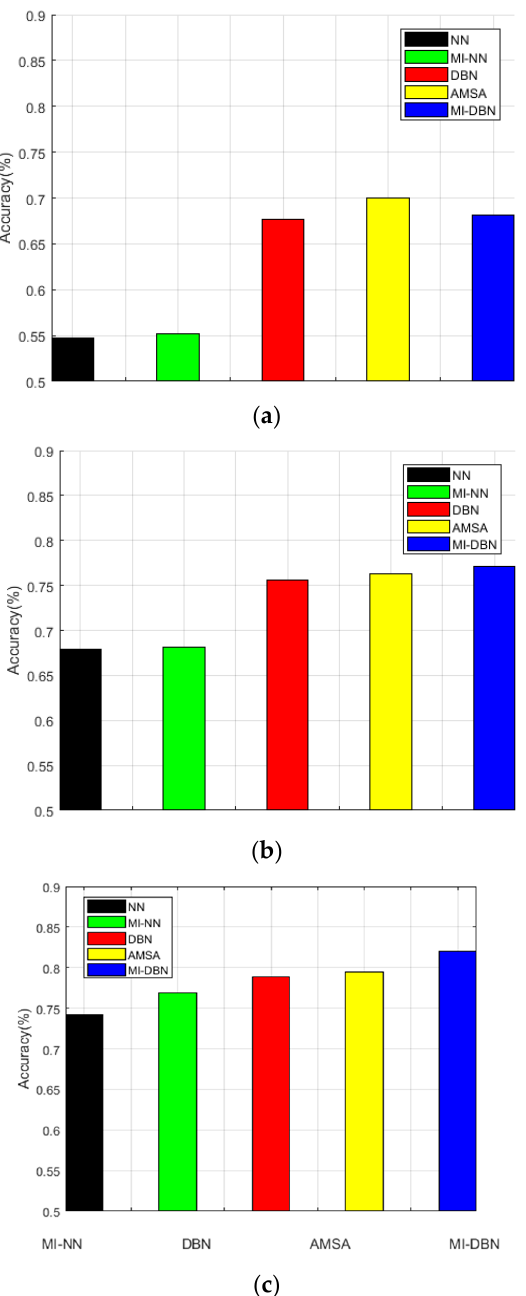
Figure 2. The tests of NN, MI-NN, DBN, AMSA, and MI-DBN with Iris. The accuracies are plotted on the horizontal axis. ( a ) α = 10%; ( b ) α = 30%; ( c ) α =